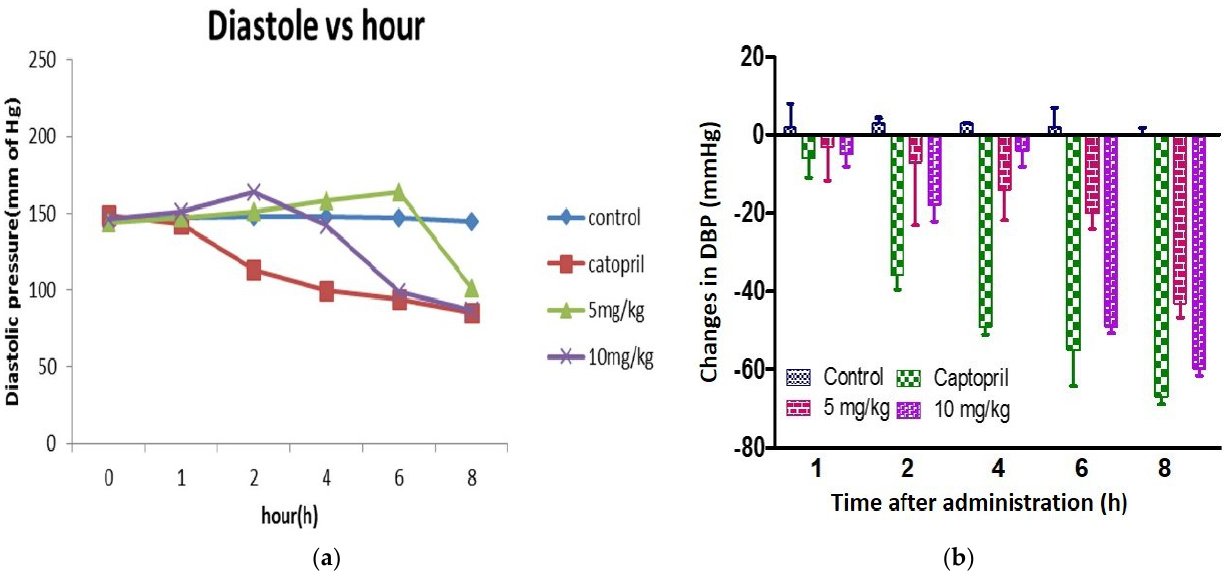
Figure 18. ( a , b ): Decrease in diastolic blood pressure (DBP) in hypertensive rats.